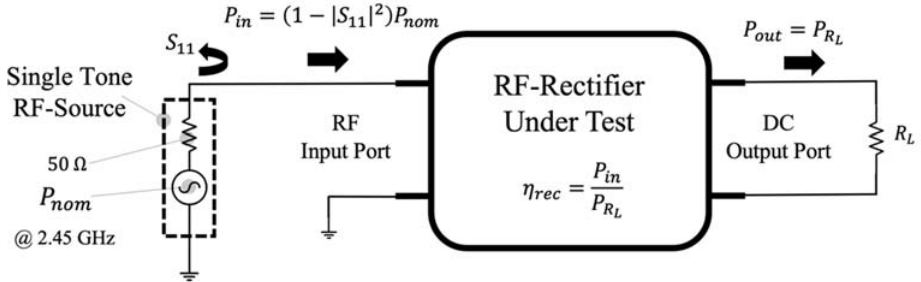
Figure 1. Simulation setup to evaluate the intrinsic efficiency η rec of the different rectifiers included in Table 1, using harmonic balance analysis with a 50 Ω single-tone source operating at 2.45 GHz. The different rectifier circuits have been simulated using identical elements. The SMS- 7630 Schottky diode model has been chosen because of its low forward voltage (ranging from 60 to 120 mV at 0.1 mA [33]). The rectifier output capacitors have been fixed to the standard value of 4.7 µ F in all cases for the simulations. The analysis of the efficiency as a bidimensional function on P in and R L points out the existence of different combinations that optimize the efficiency. Figure 2 shows, as example, the simulated η rec ( P in , R L ) for the N = 2 Dickson rectifier circuit. As it can be observed, there are multiple P in and R L combinations producing the maximum efficiency (close to 70%). It is also observed that for the expected ambient RF power ( P in ≤ − 30 dBm), the maximum DC conversion efficiencies are lower than 30%, which are higher than 10% only in the range of 1 k Ω < R L < 300 k Ω . but renders the comparison between rectifiers